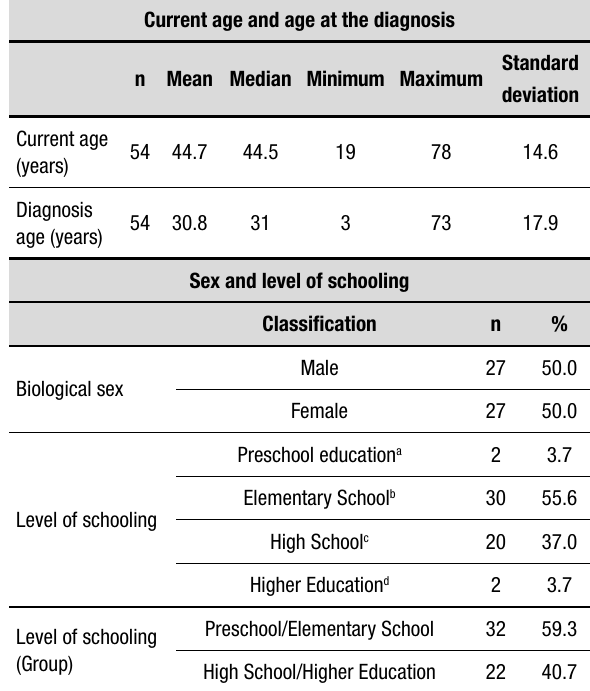
Table 1. Demographic variables of the participants of the study (n=54). Current age and age at the diagnosis